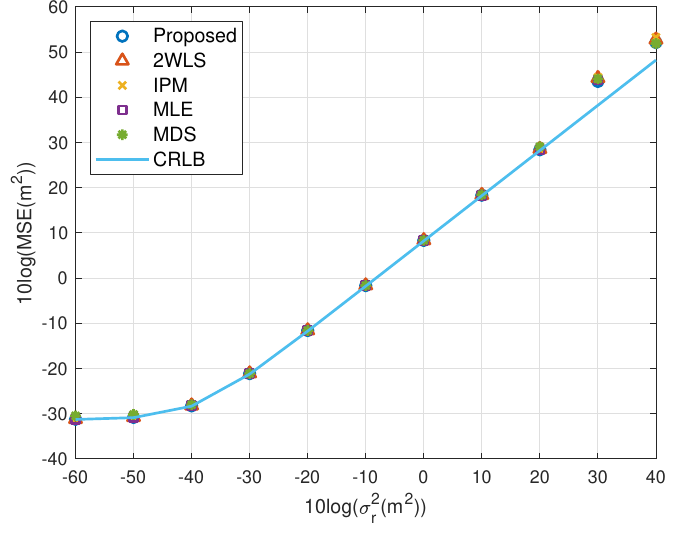
Figure 10. MSE performance as noise power increasing (near source, 6 sensors).